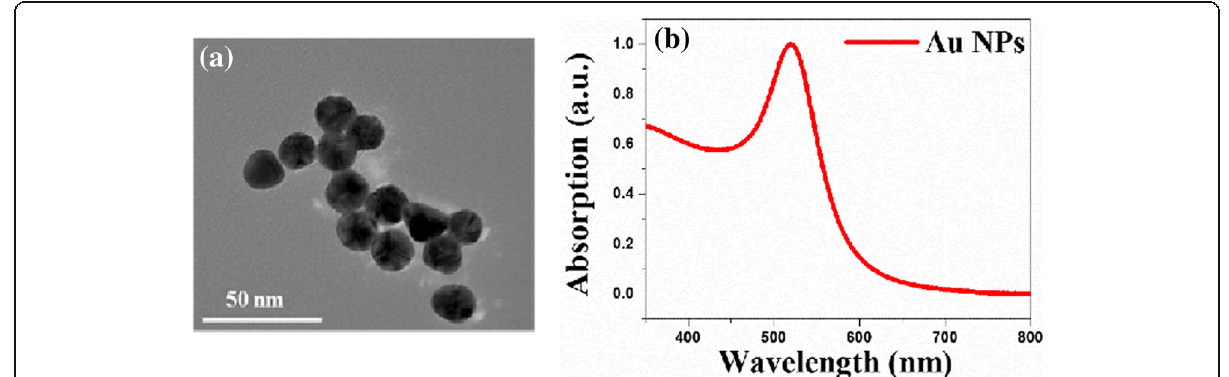
Fig. 1 a TEM image. b Absorption spectra of Au NPs